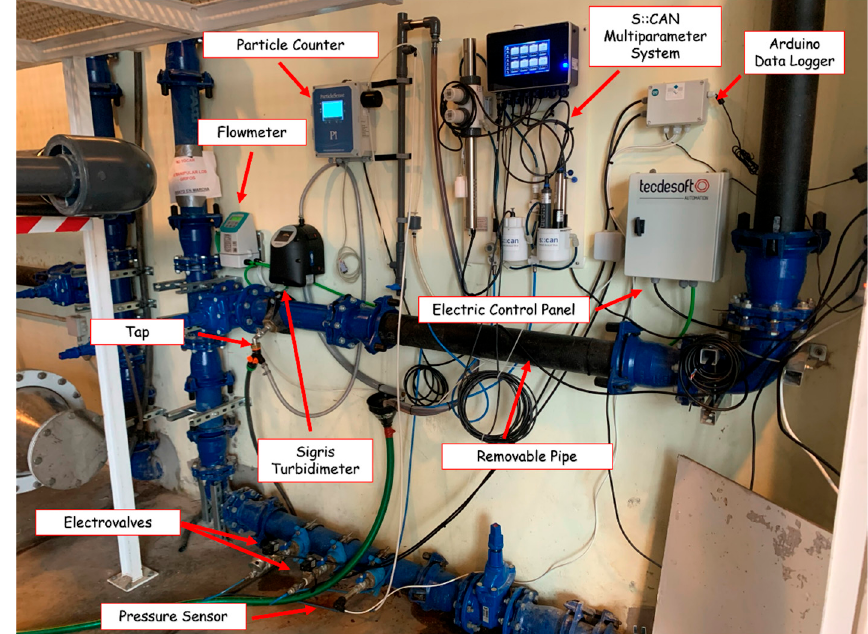
Figure 2. Distribution of relevant elements in the piping panel.